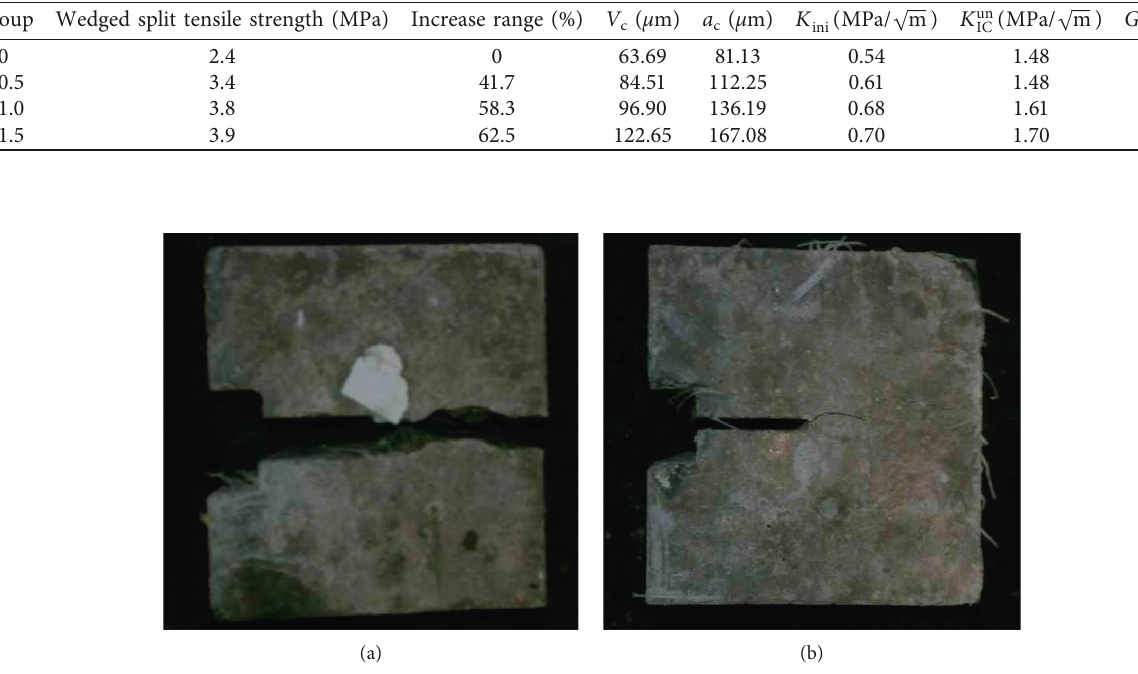
Table 6: Wedged split tensile test results.